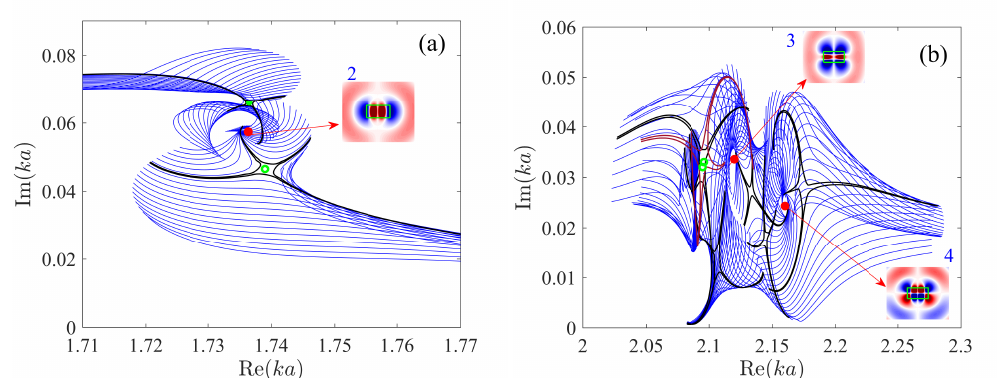
Figure 4. ( a , b ). Evolution of the eigenfrequencies of four disks for variation of the distances 1 ≤ D ≤ 2.5 and 0.06 ≤ L ≤ 1.06. Each line evolves with L at fixed D . Red closed circles marks the eigenfrequencies of single disk with h = 1.04 and (cid:101) = 12. Green open and closed circles mark symmetrical and anti-symmetrical EPs.